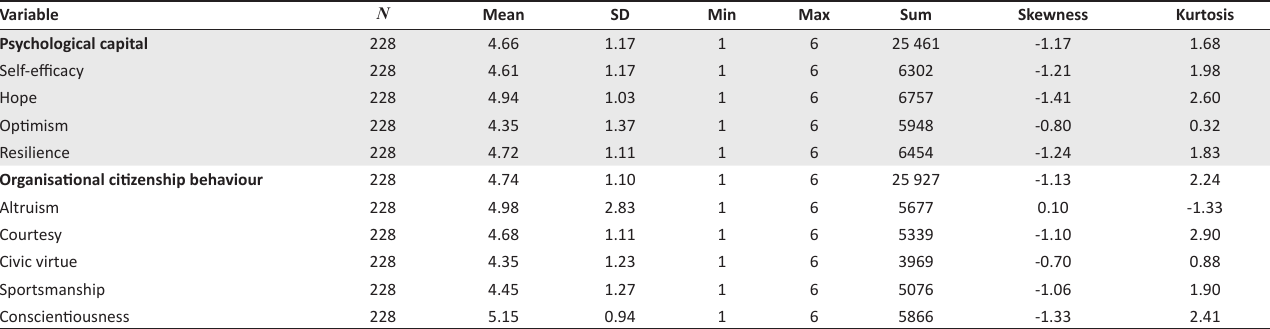
TABLE 1: Summary of descriptive statistics.